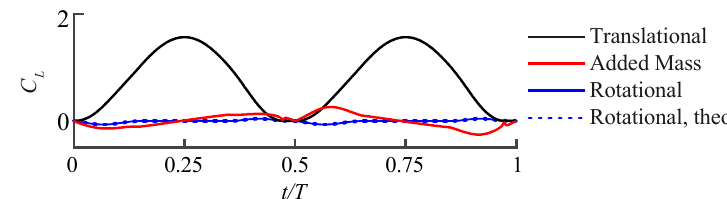
Figure 17. Plots of the translational (black), added mass (red), rotational (blue) and theoretical rotational